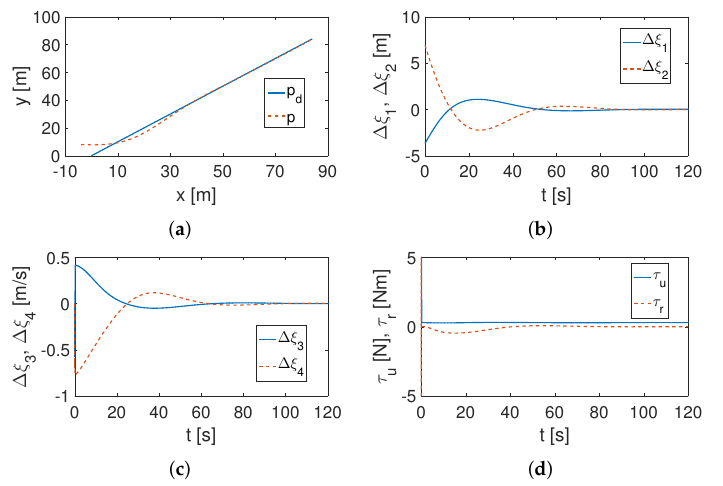
Figure 7. Simulation results for XX AUV original controller (CL) and linear trajectory: ( a ) desired and realized trajectory; ( b ) position error states; ( c ) velocity error states; and ( d ) applied force and torque. The kinetic energy average values are K m = 19.04 J (and K m 1 = 5.34, K m 2 = 19.69, K m 3 =